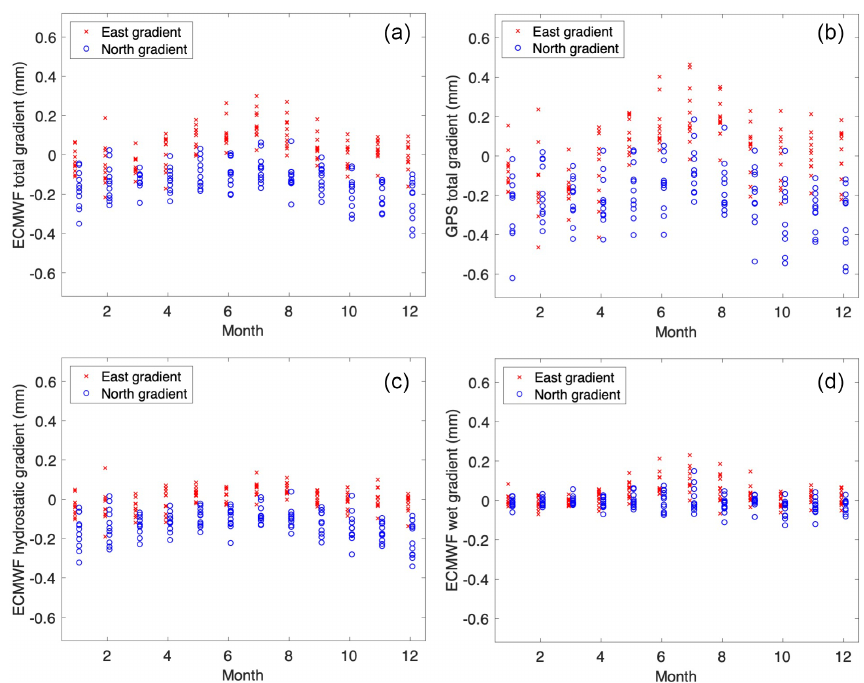
Figure 9. Monthly means of estimated gradients at the ONSA station for the period 2006–2016. The top graphs show the total gradients from ECMWF (a) and GPS (b) . The graphs at the bottom show the ECMWF gradients when separated into the hydrostatic (c) and the wet gradient (d) . Table 5. Correlation coefficients for the total east and north gradients estimated from GPS data and compared to ECMWF data. Station Six hourly Daily Monthly East North East North East North Kiruna (KIR0) 0.55